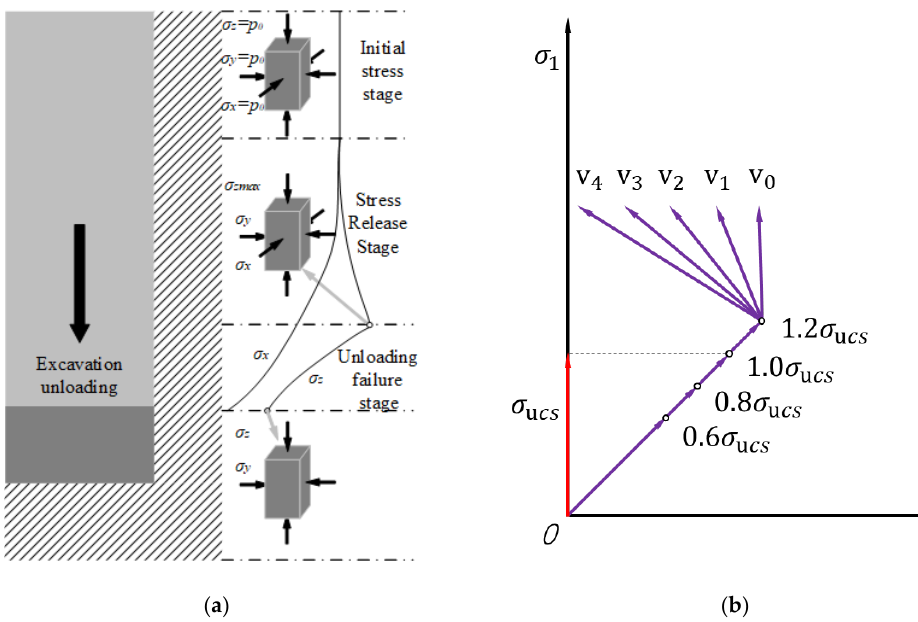
Figure 1. Illustration of failure mechanism of: ( a ) Rock masses under unloading conditions; ( b ) stress path of unloading experiment.